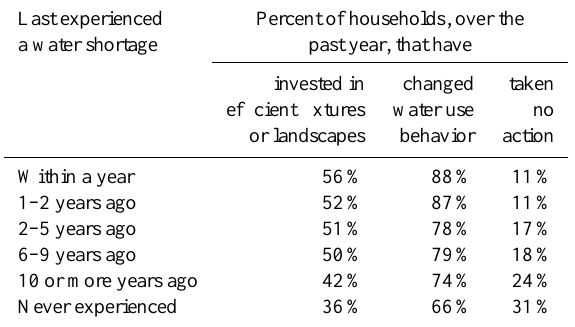
Table 2. Household conservation action by shortage experience (ISTPP,